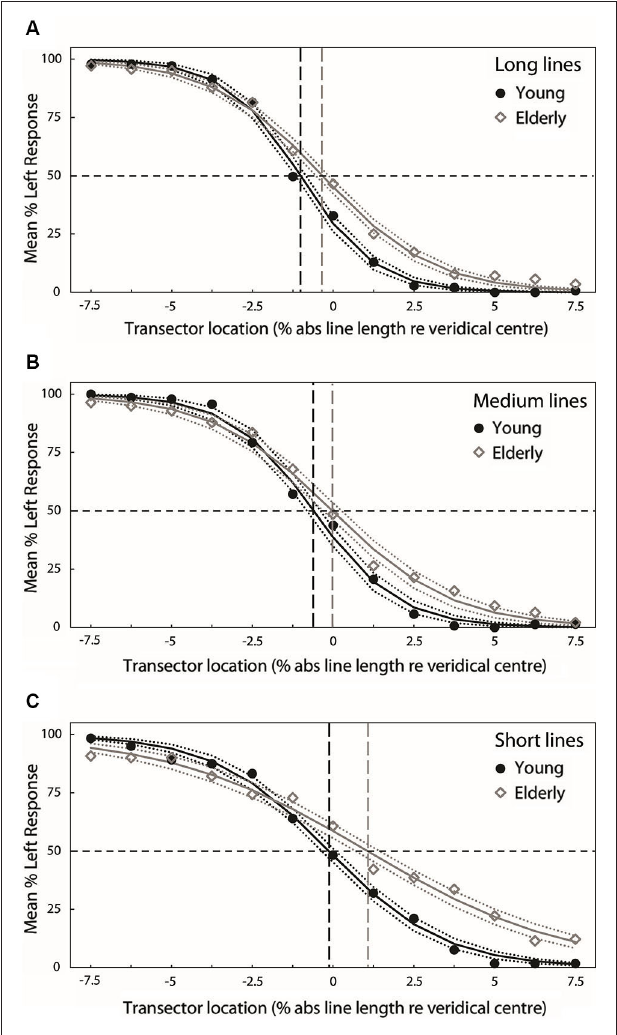
FIGURE 3 | Group-averaged PFs for both experimental groups at each line length (A = long, B = medium, C = short) . For each line length, black filled circle symbols (young participants) and gray open diamond symbols (elderly participants) plot mean percentage left response as a function of transector location. The black (young) and gray (elderly) smooth curves represent the best-fitting least-squares cumulative logistic PFs (95% confidence interval represented by black (young) and gray (elderly) dotted lines). Where black (young) and gray (elderly) vertical dashed lines cross the black horizontal dashed lines indicate the transector locations corresponding to the 50% response rates